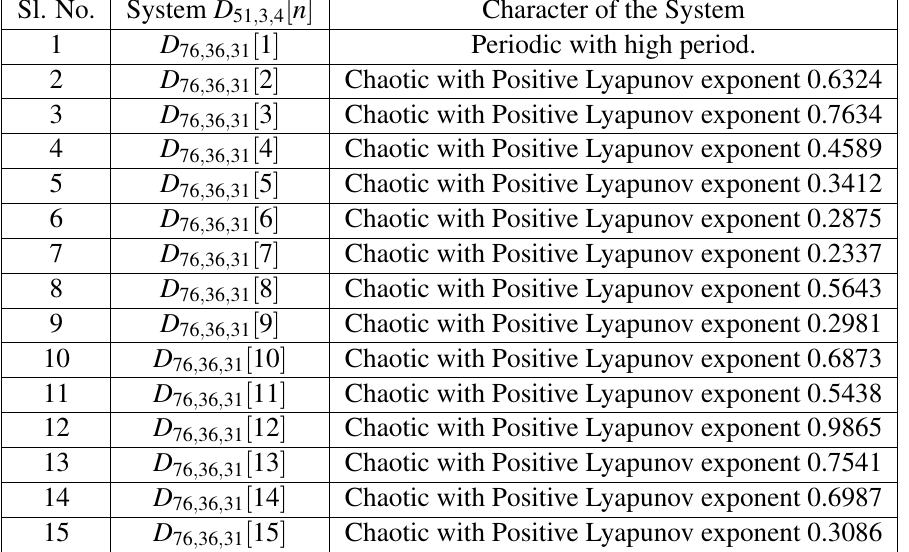
Table 2 Transition of the dynamical behavior of the system D 51 , 3 , 4 [ n ] according as the degree of the system n varying from 1 to 15.